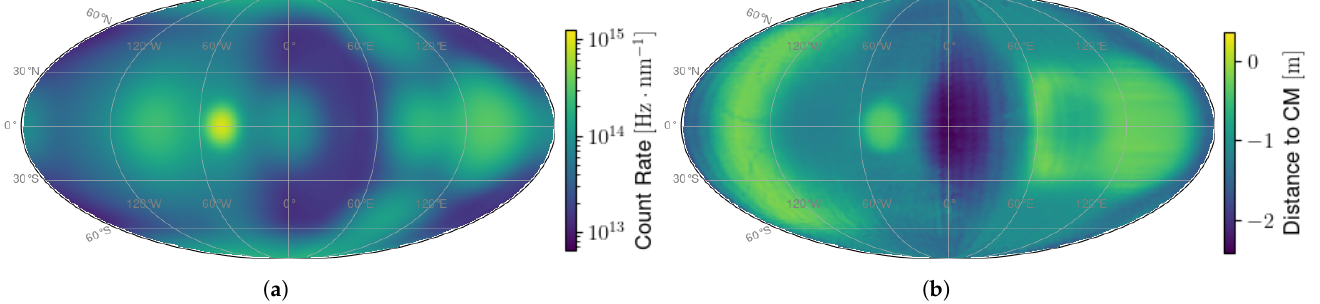
Figure 16. Retroreflective simulations of the box-wing satellite depicted in Figure 4 under solar illumin- ation, measured in the G-638/26 band. ( a ) Passive reflection. ( b ) Mean theoretical ranging estimate.